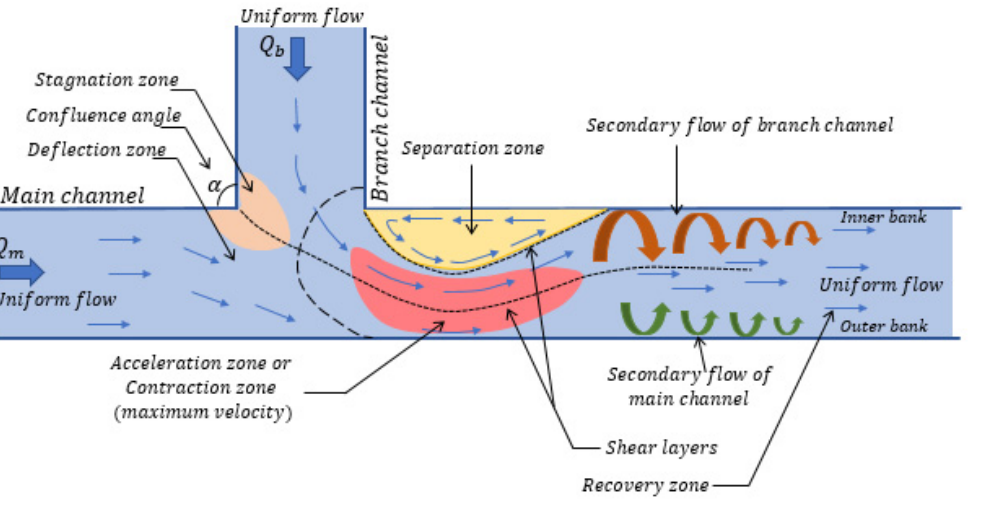
Figure 2 . Flow pattern in a confluent channel (based on [18], from [15]) , and secondary flow struc- Figure 2. Flow pattern in a confluent channel (based on [18], from [15]), and secondary flow structure ture in a confluent channel (based on [17] after [19], (developed from [20]). in a confluent channel (based on [17] after [19], (developed from